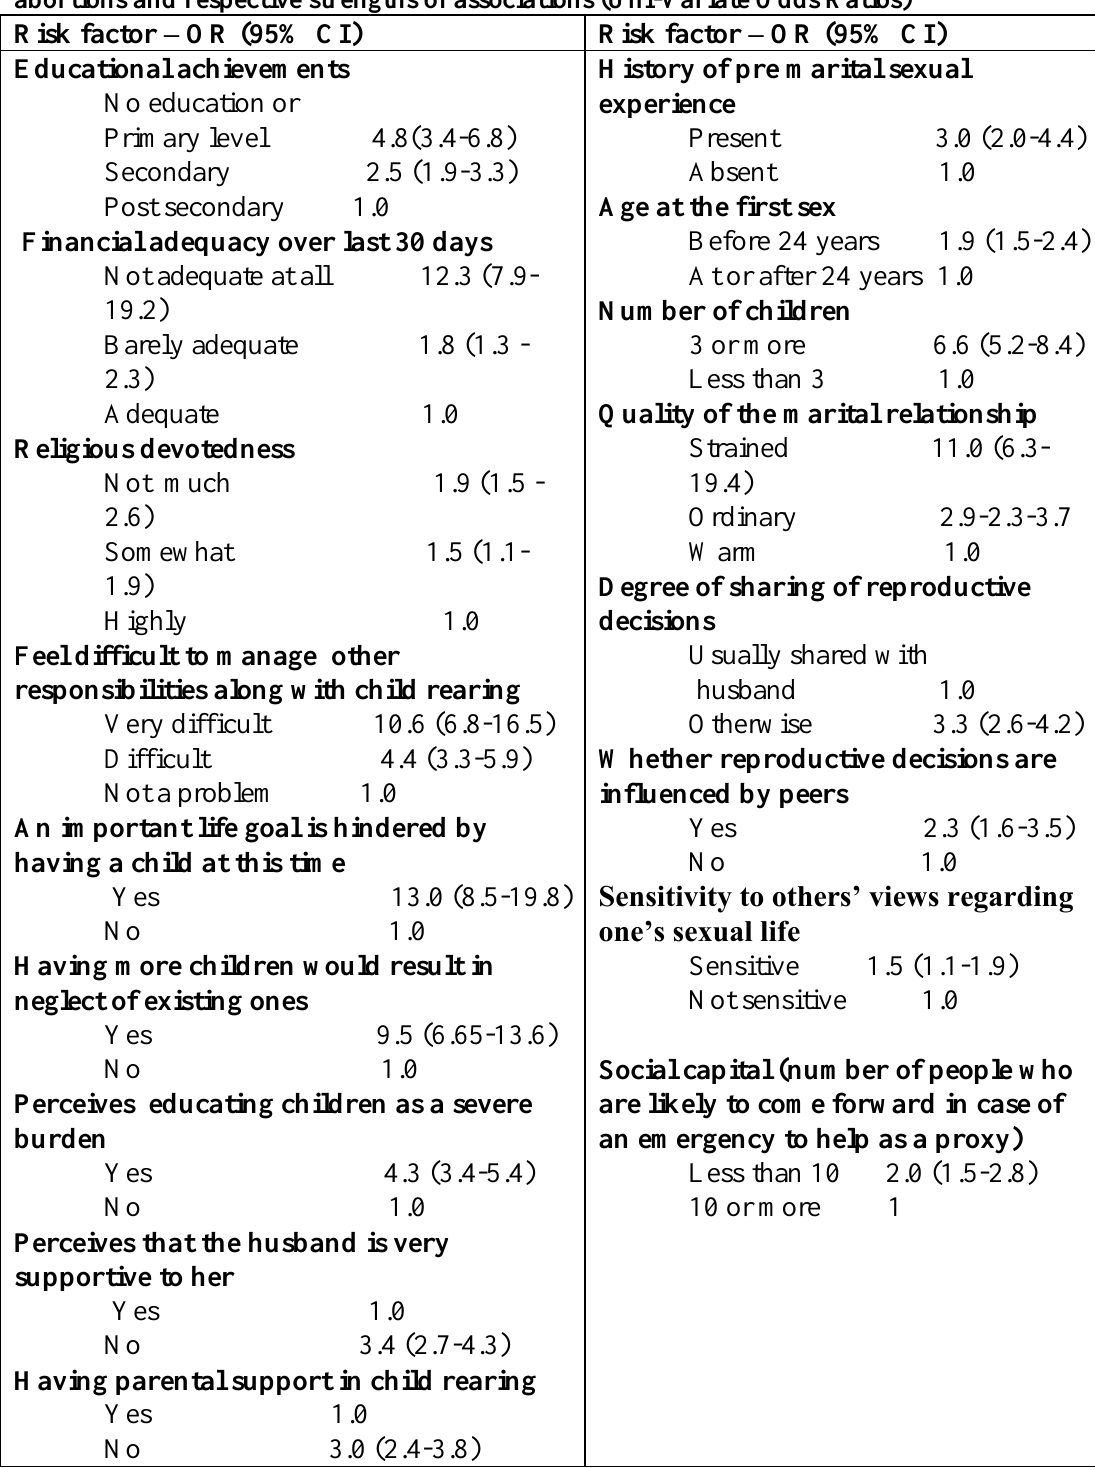
Table 3: Factors that are found to be Associated with the tendency for resorting to induced abortions and respective strengths of associations (Uni-Variate Odds Ratios) Risk factor – OR (95%